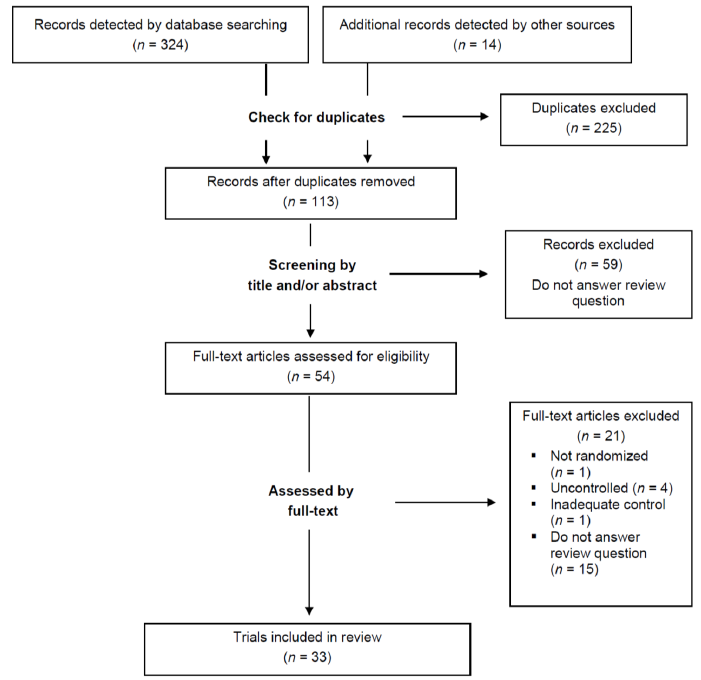
Figure 1. Flow diagram of study selection process.